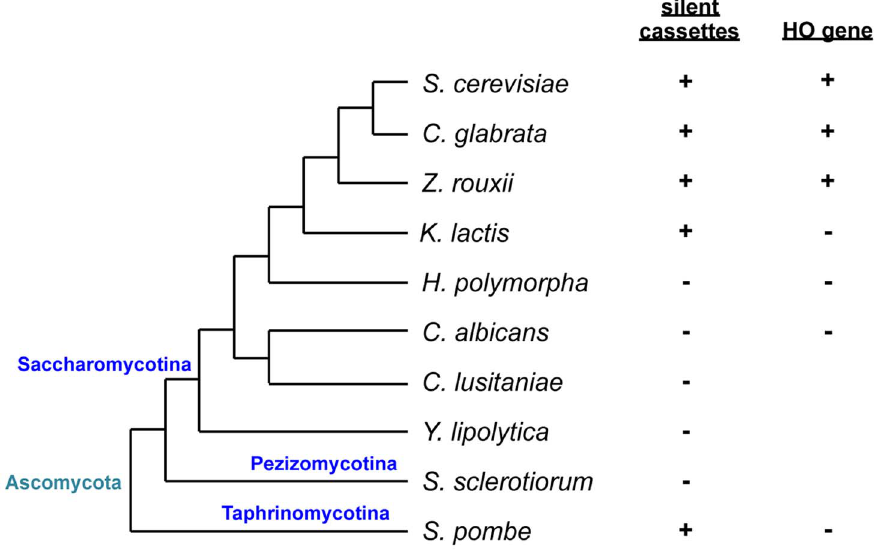
Figure 1. Schematic of phylogenetic relationships among yeast species and conservation of silent mating type cassettes and the HO gene. Information on silent cassettes and the HO gene is based on ref. 13. The tree is not drawn to scale.